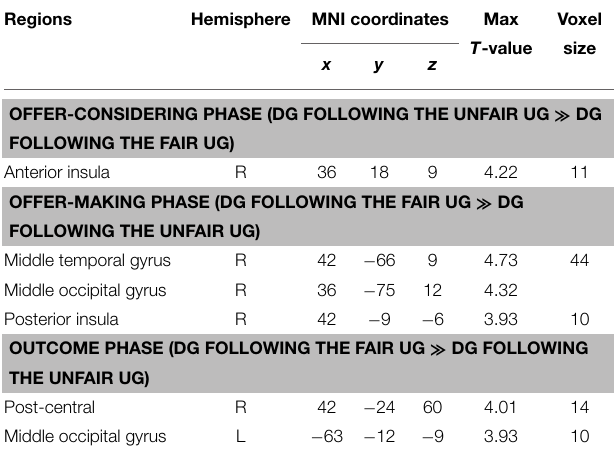
TABLE 1 | Significant activation for the contrasts of the DG following fair vs. unfair treatment. Regions Hemisphere MNI coordinates Max Voxel T -value size x y